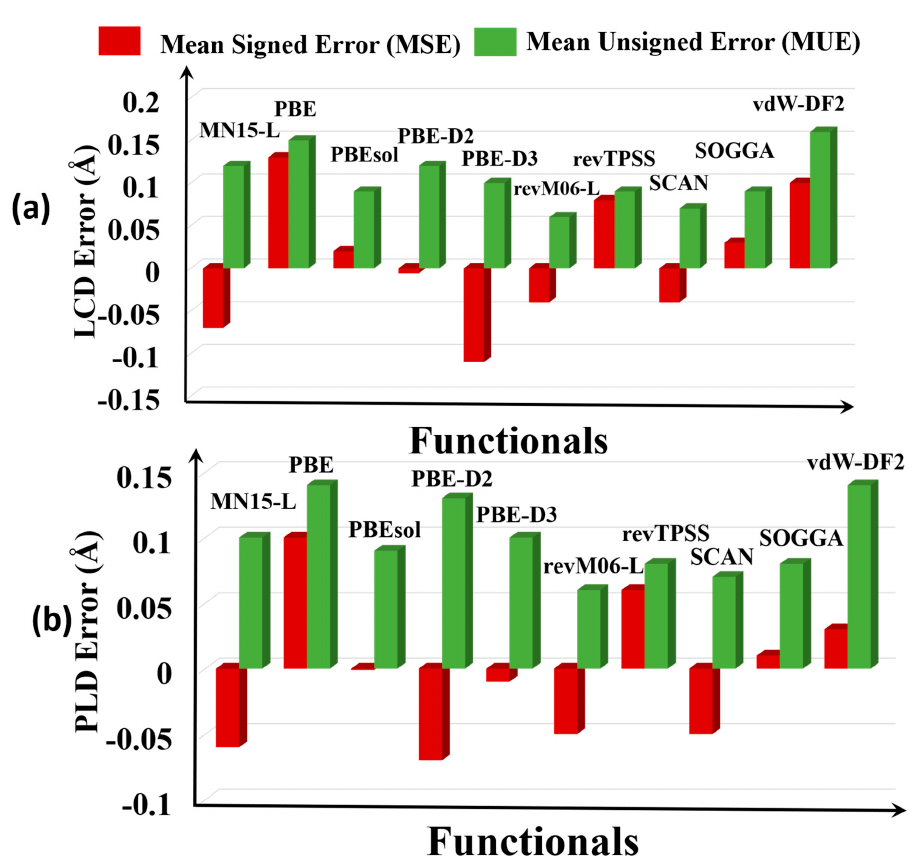
Figure 3. Graphical representation of the errors of pore sizes: ( a ) largest cavity diameters (LCDs) and ( b ) pore limiting diameters (PLDs).